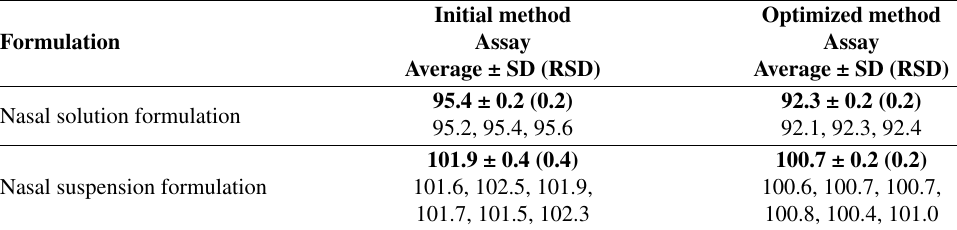
Table 9. Comparison of the analysis results of two different types of samples analyzed using the initial procedure and the proposed optimized analytical method procedure. Average assay ± SD (RSD) of the individual measure- ments are